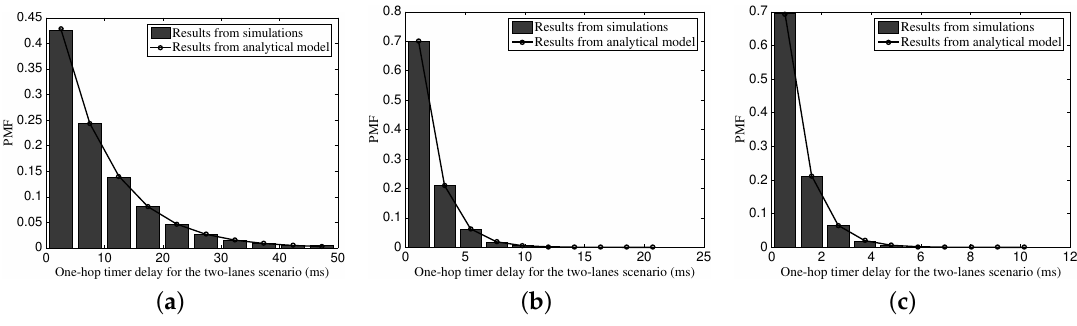
Figure 10. The PMF of one-hop timer delay for the two-lane scenario with different vehicular traffic density, where v ∆ = 20 km/h. ( a ) ρ 1 = 10, ρ 2 = 5 vehs/km; ( b ) ρ 1 = 50, ρ 2 = 25 vehs/km; ( c ) ρ 1 = 100, ρ 2 = 50